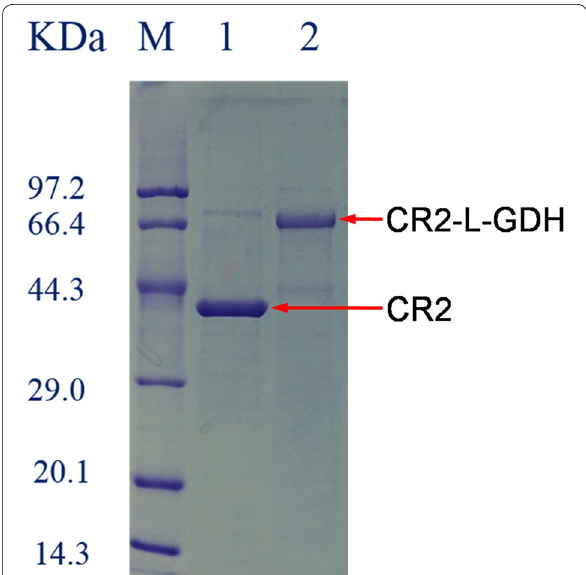
Fig. 3 SDS-PAGE analysis of the recombinant CR2 and the fusion protein CR2-L-GDH. Lane M Protein molecular weight marker; lane 1 recombinant CR2; lane 2 fusion protein CR2-L-GDH